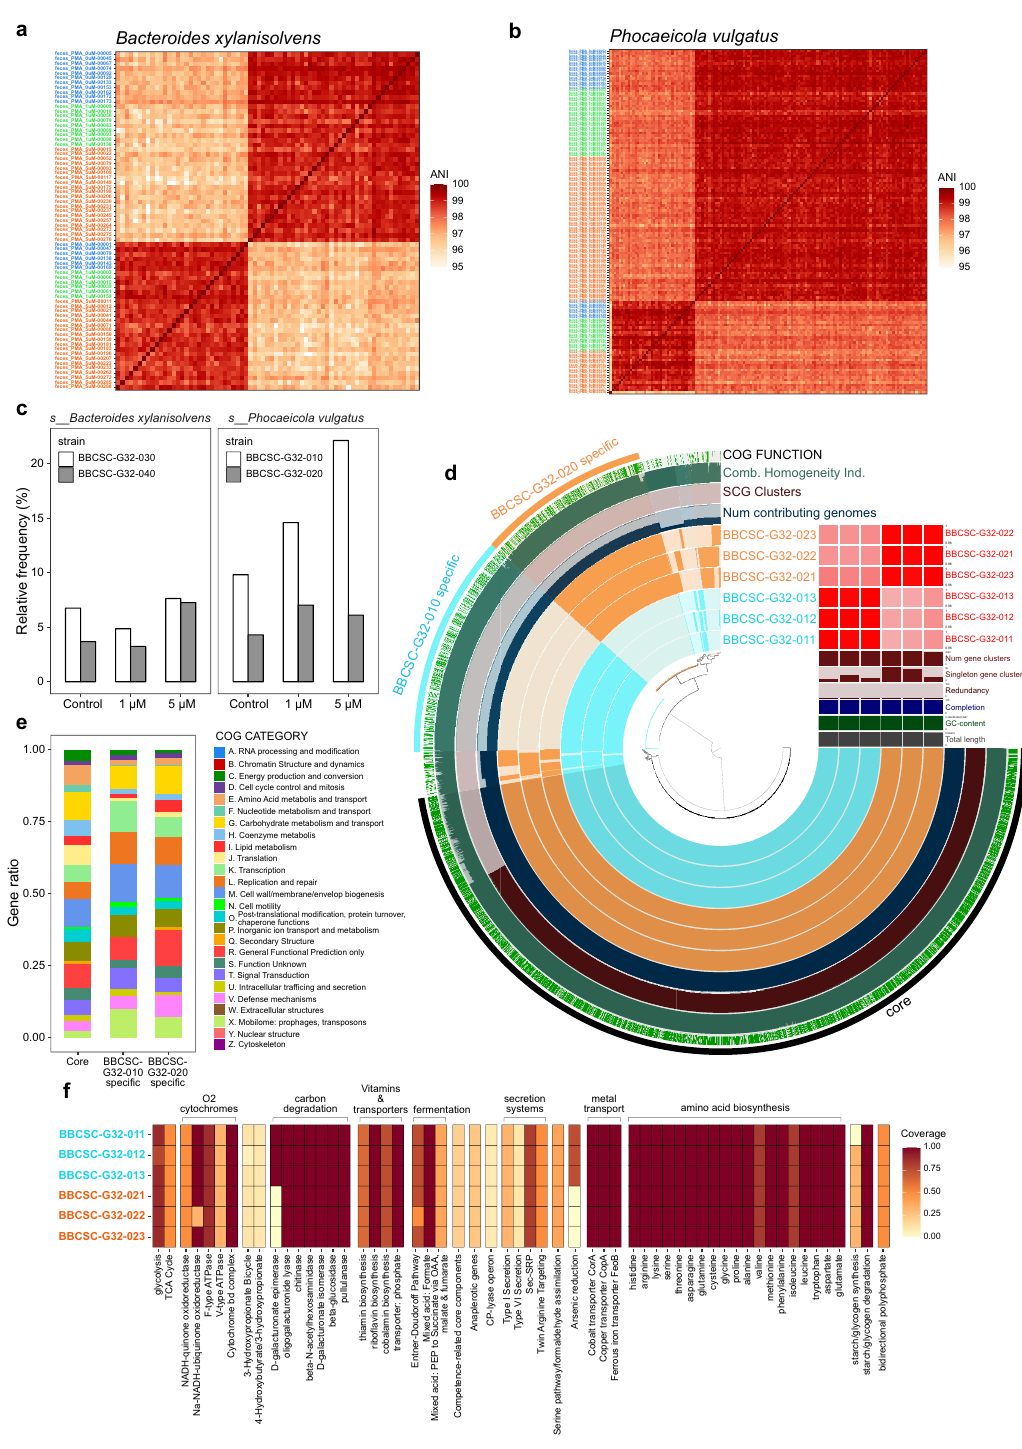
Figure 5. Strain-level genome analysis of Bacteroidaceae bacteria obtained from human feces. ( a , b ) Hierarchical clustering of pairwise average nucleotide identity (ANI) values across SAGs in Bacteroides xylanisolvens ( a ) and Phocaeicola vulgatus ( b ). SAGs for which ANI can be calculated for more than 75% of same-species SAGs, and the maximum ANI was more than 98.5%, were adopted as the data set. ( c ) Relative abundance of B. xylanisolvens (BBCSC-G32-030 and BBCSC-G32-040) and P. vulgatus (BBCSC-G32-010 and BBCSC-G32-020) strains as functions of PMA treatment concentration. ( d ) Anvi’ o representation of P. vulgatus composite SAGs obtained from each PMA concentration. The first six layers represent each genome, and the blue/orange coloration indicates the existence of a gene cluster (GC). To the right is given an ANI percentage identity heatmap of the same genomes. The subsequent three layers correspond to various statistics related to the analysis, that is, the number of contributing genomes per GC, species core genome clusters, homogeneity index, and cluster of orthologous groups of proteins (COG) function. The outer green layer describes the gene groups in which at least one gene was functionally annotated using COGs. ( e ) COGs distributions in core and accessory genes of the two P. vulgatus strains. ( f ) KEGG Decoder heat map of the two P. vulgatus strains based on KEGG annotation. The heat map represents the metabolic pathway completeness of the SAGs based on the presence or absence of